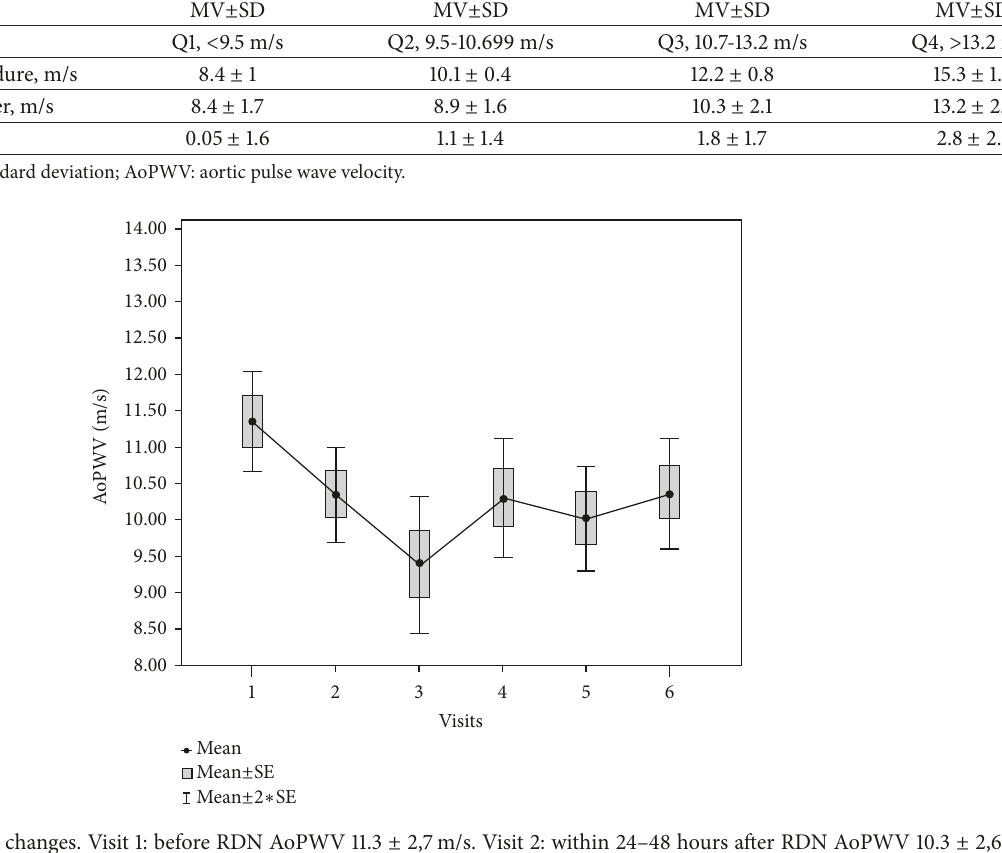
Figure 1: Aortic PWV changes. Visit 1: before RDN AoPWV 11.3 ± 2,7 m/s. Visit 2: within 24–48 hours after RDN AoPWV 10.3 ± 2,6 m/s ( p < 0.001). Visit 3: after 1 month AoPWV 9.4 ± 2,2 m/s ( p < 0.001). Visit 4: after 3 months AoPWV 10.3 ± 2,9 m/s ( p =0.013). Visit 5: after 6 months AoPWV 10 ± 2,6 m/s ( p < 0.001). Visit 6: after 1 year AoPWV 10.4 ± 2.7, p=